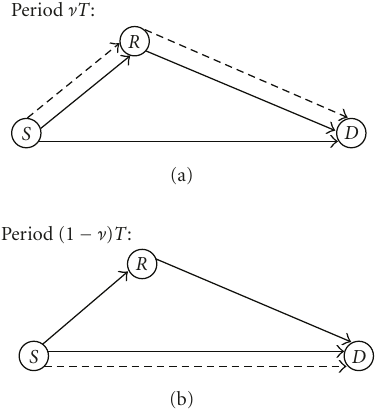
Figure 3: Block diagram for the communication protocol for the RC with independent interferences. Solid lines correspond to transmission of message W a and dashed lines correspond to transmission of message W d . Message W a is precoded against the interference S a , i using a GDPC, during both periods. Message W d is precoded using standard DPC, against the interference (1 − α a ) S a , i + S d , i during the period ν T and against the interference (1 − α a ) S a , i − S d , i during the period (1 − ν ) T